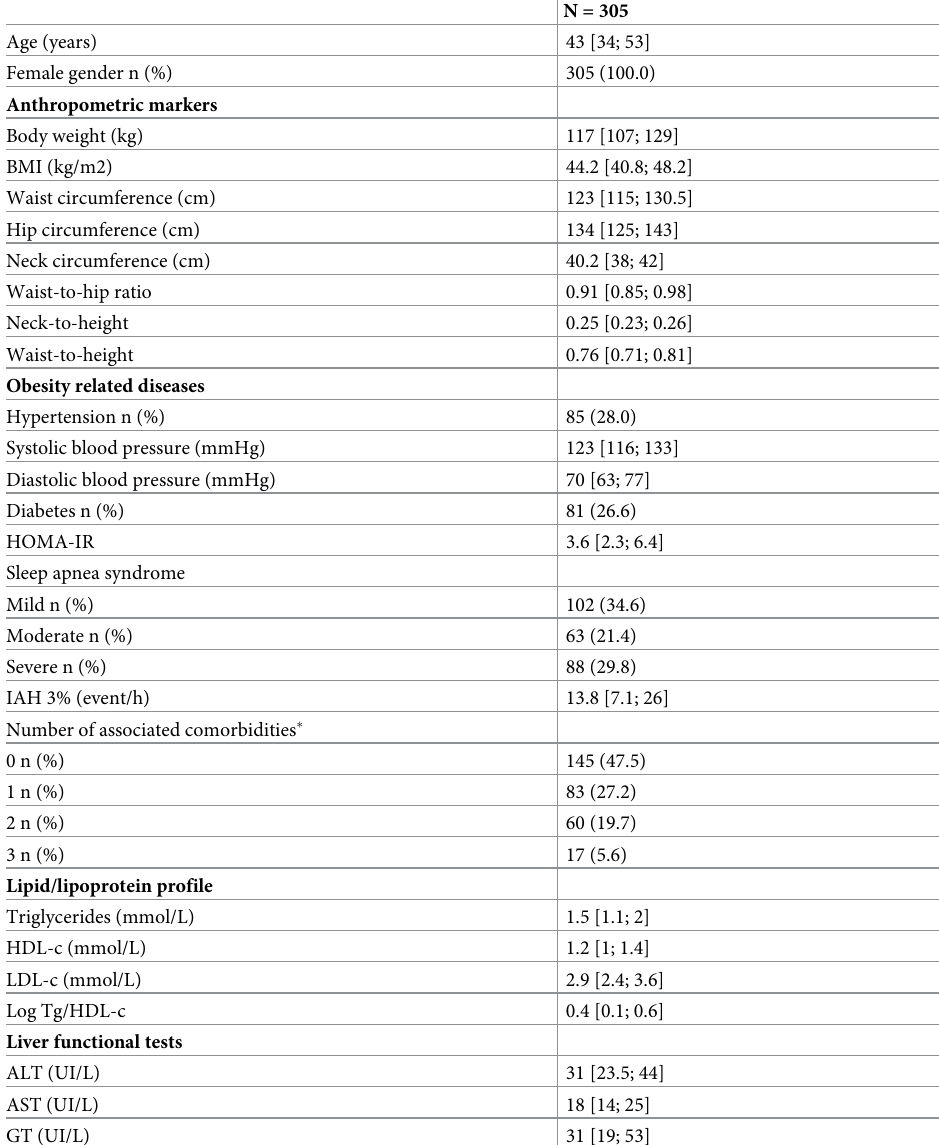
Table 1. Patient